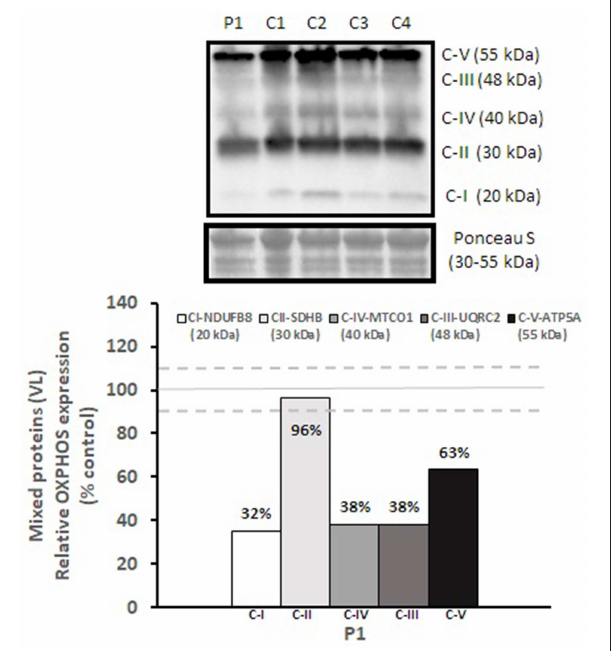
FIGURE 2 | OXPHOS expression in vastus lateralis muscle. Complex I, II, III, IV, and V expression in vastus lateralis muscle were normalized to total protein (Ponceau S) and presented as a percentage of healthy, gender, and age-matched controls ( N = 4). Solid gray line indicates normal protein levels (e.g., control mean is 100%) and dashed lines are bidirectional standard errors calculated from the absolute values, control mean, and N .